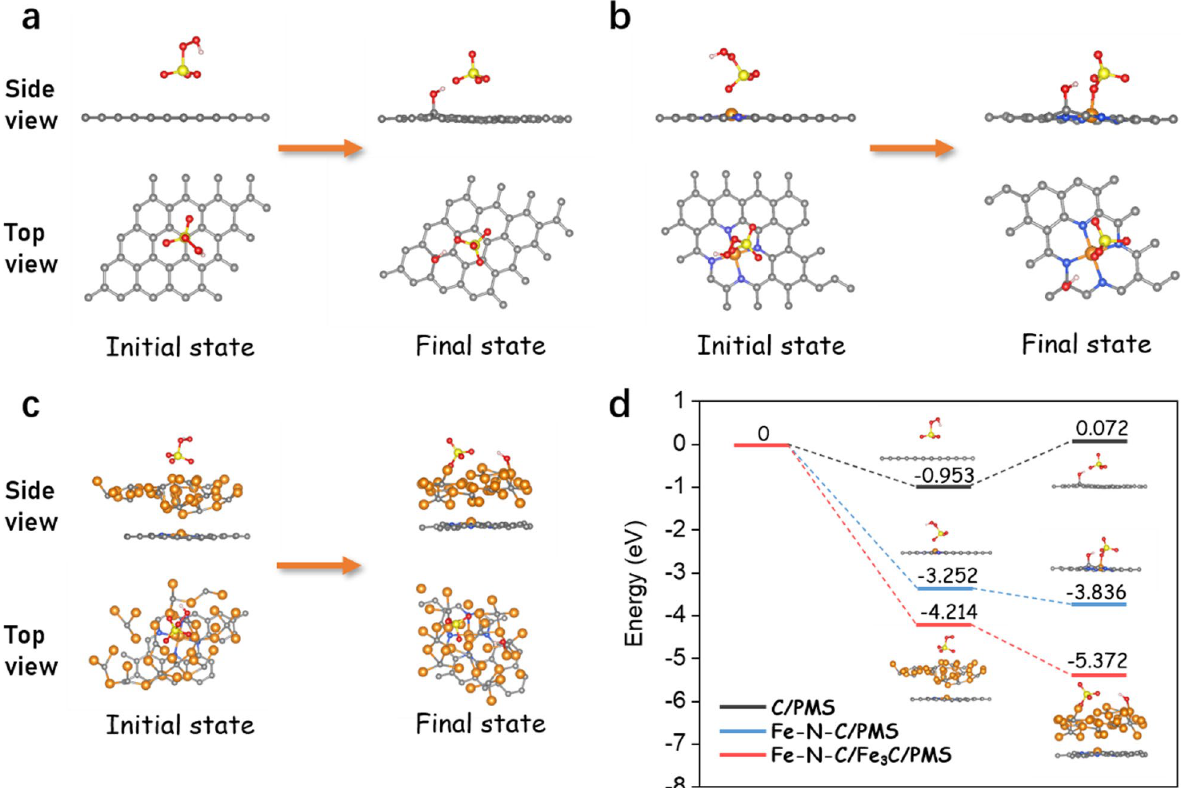
Fig. 6 Structure of PMS molecules adsorbed on ( a ) C, ( b ) Fe–N-C and ( c ) Fe–N-C/Fe 3 C. d Schematic illustration and calculated potential energy profiles of PMS dissociation processes over the different